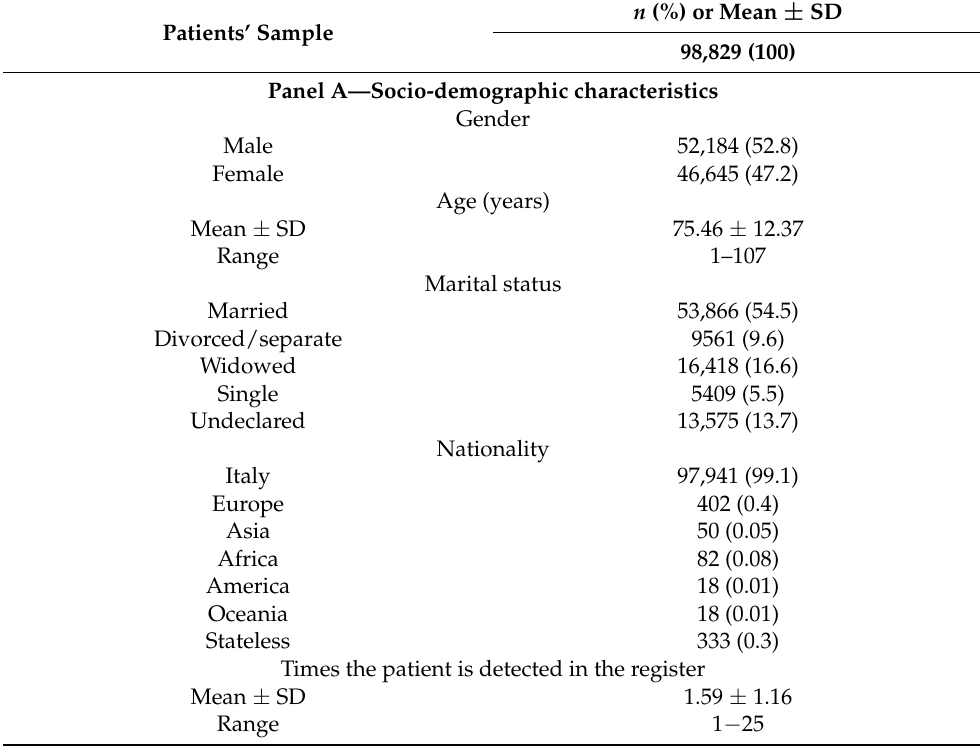
Table 2. Patient